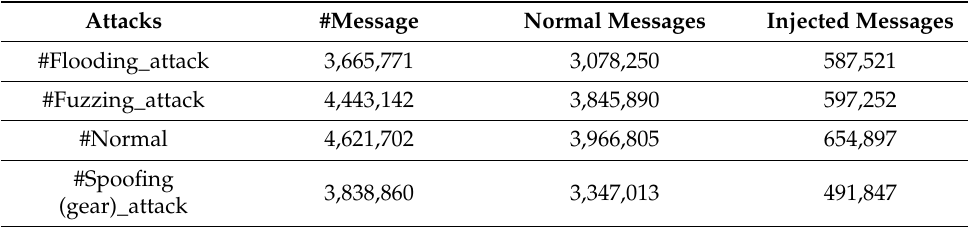
Table 1. Total numbers of injected messages for each